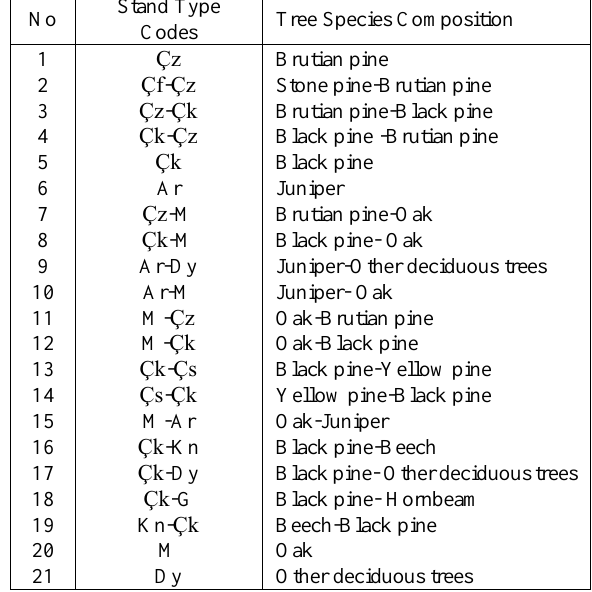
Table 2. Tree species and species compositions in the study area